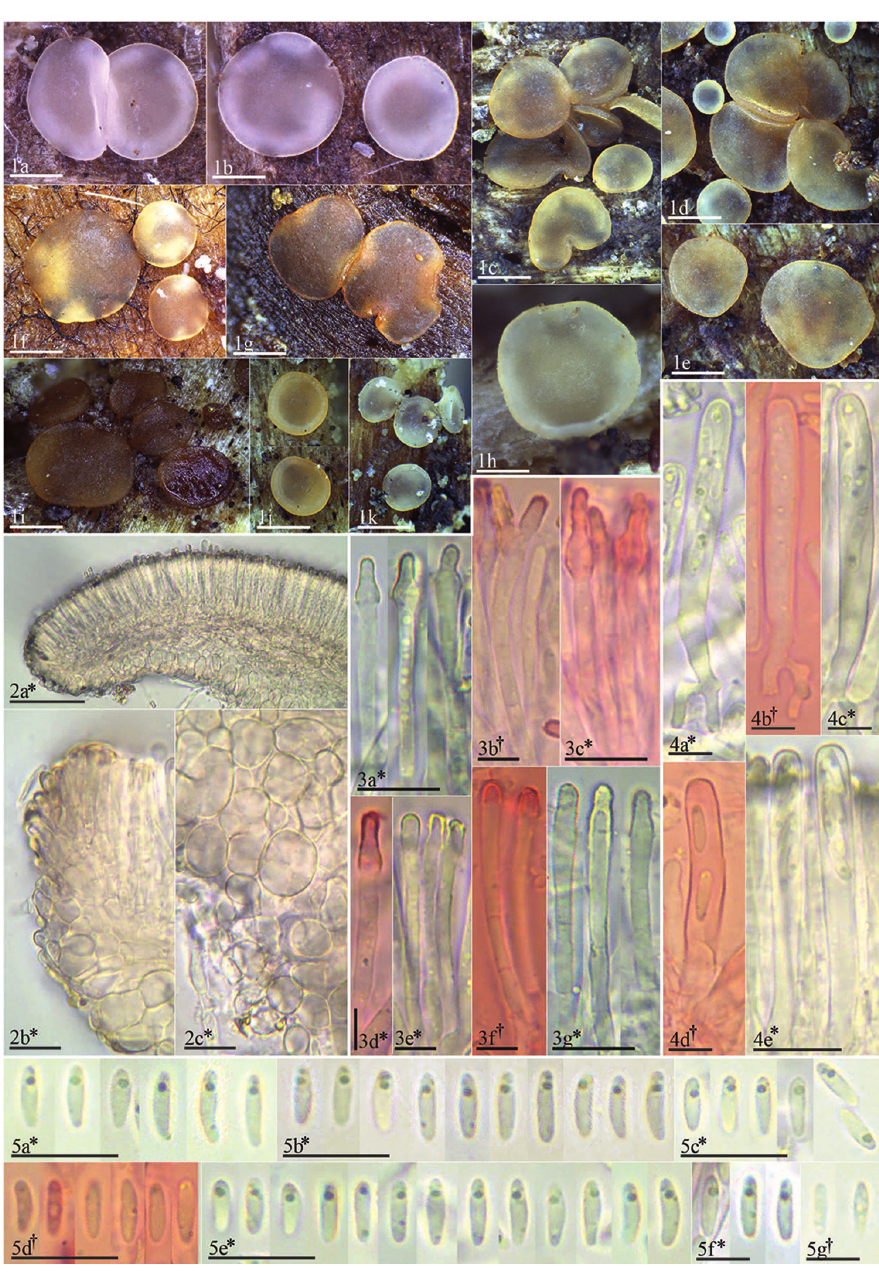
Figure 3. Morphological features of Orbilia beltraniae . 1 Apothecia rehydrated after 1–2 weeks 2 Excip- ular tissues in median section 3 Paraphyses 4 Asci 5 Ascospores. Scale bars: 500 µm= 1a–k ; 50 µm= 2a ; 10 µm= 2b–c, 3a, c, g, 4e, 5a–e ; 5 µm= 3b, d–f, 4a–d, 5f ; Mounted in: CR= 3b–d, 4b, d, 5d ; H2O= 2a–c, 3a, e–g, 4a, c, e, 5a–c, e–g . Photos: TFC Mic. 23771 = 1i–k, 3b–c, 4b, 5a ; TFC Mic. 23836 = 1h, 2c, 3d–e, 5b ; TFC Mic. 23890 = 1d–e, 4a, 5f ; TFC Mic. 23902 = 1f–g, 3a, 4c ; TFC Mic. 24231 = 2a, 3g, 5c, g ; TFC Mic. 24363 = 1c, 2b, 3f, 4d–e, 5d–e ; TFC Mic. 24449 = 1a–b